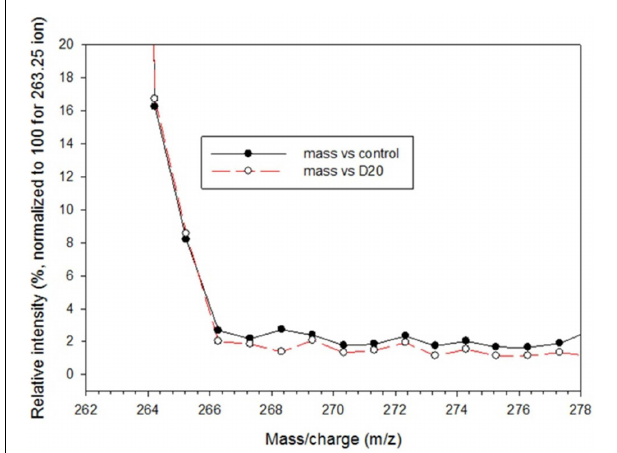
FIGURE 9 | Mass spectrometric analysis of thiamin vitamers extracted from D 2 O labeled maize leaf slices and analyzed as thiochrome. Leaf slices were floated on water containing 30% D 2 O and incubated in the light for 24h. Thiamin and its phosphates were extracted and converted to thiochrome. A full scan was collected from m/z 100–600 and a zoom scan was collected from m/z 260–270 to evaluate isotopic enrichment. Intensity values are normalized relative to the molecular ion signal of 263.25 (set equal to 100). The profile of isotopolog masses up to M + 13 is shown to allow detection of deuterium incorporation over a complex background due to natural stable isotope abundances of 13 C, 17 O, 18 O, 15 N, and 34 S. Data points are means of two independent